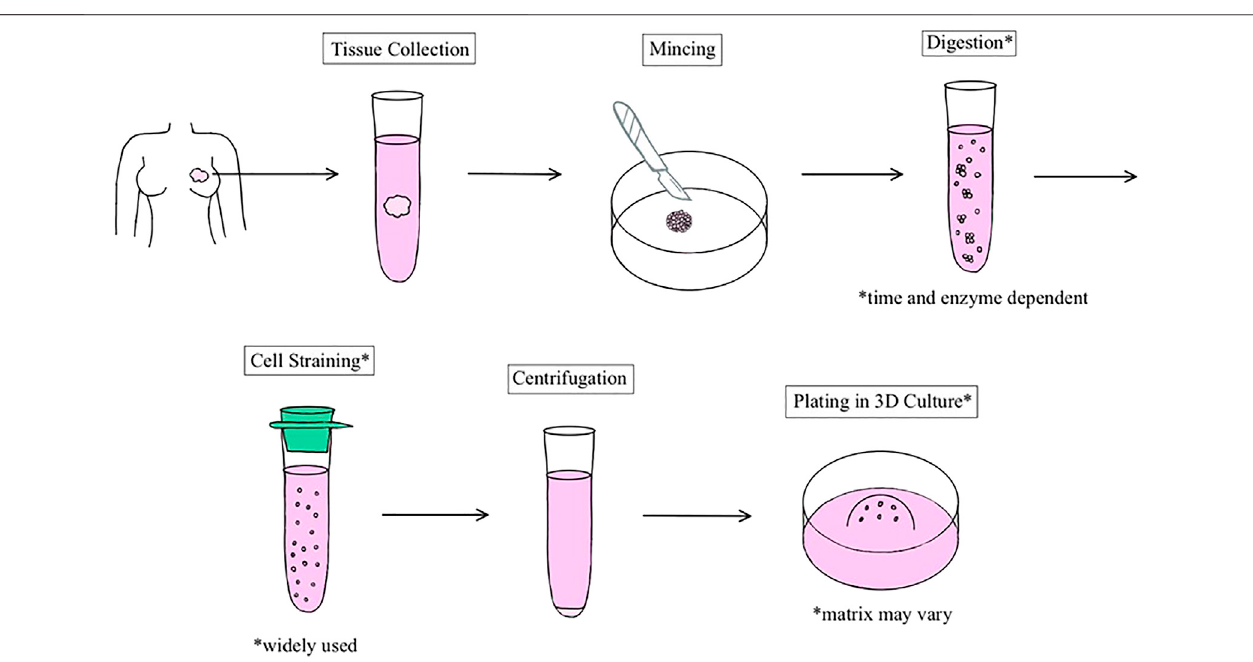
FIGURE 1 | Schematic representation of the general process of human breast organoid derivation. Organoids are established from resections of normal breast or tumor tissue.